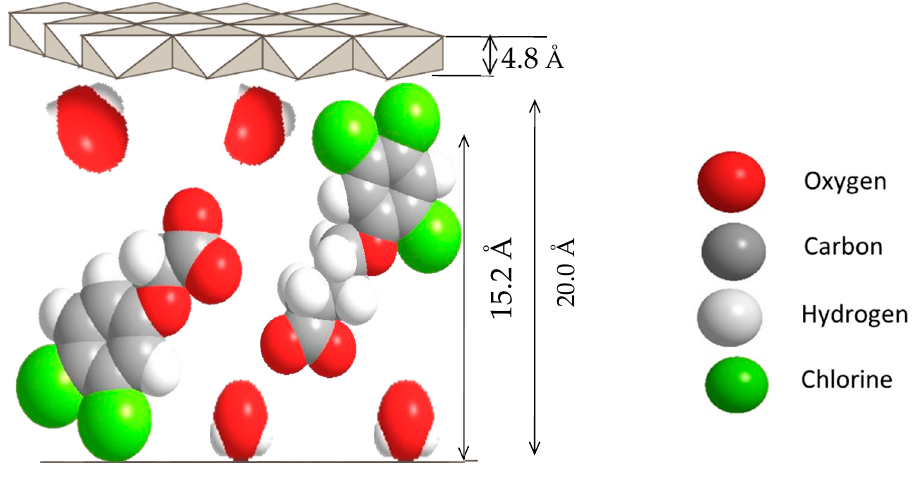
Figure 2. Proposed orientation of 3,4D and TBA in LDH interlayer for the formation of dual-guest nanocomposite ZADTX.